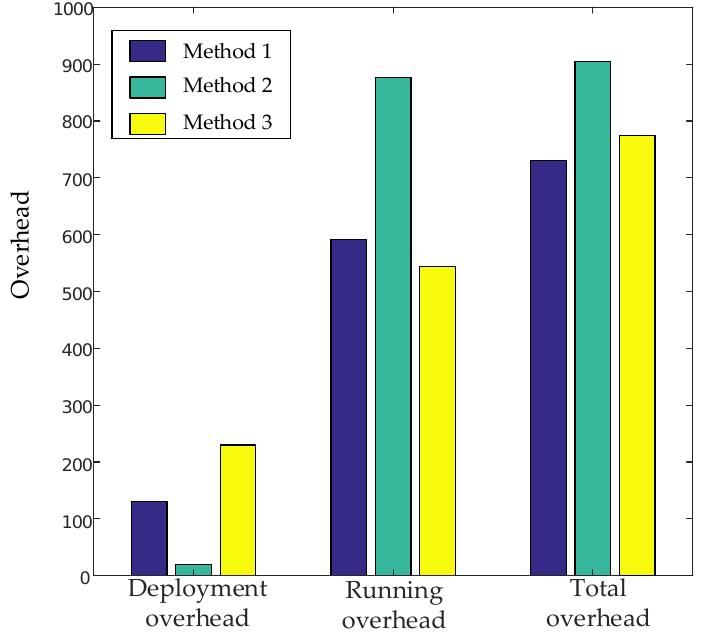
Figure 8. Comparison of network overhead among method 1, method 2, and method 3.